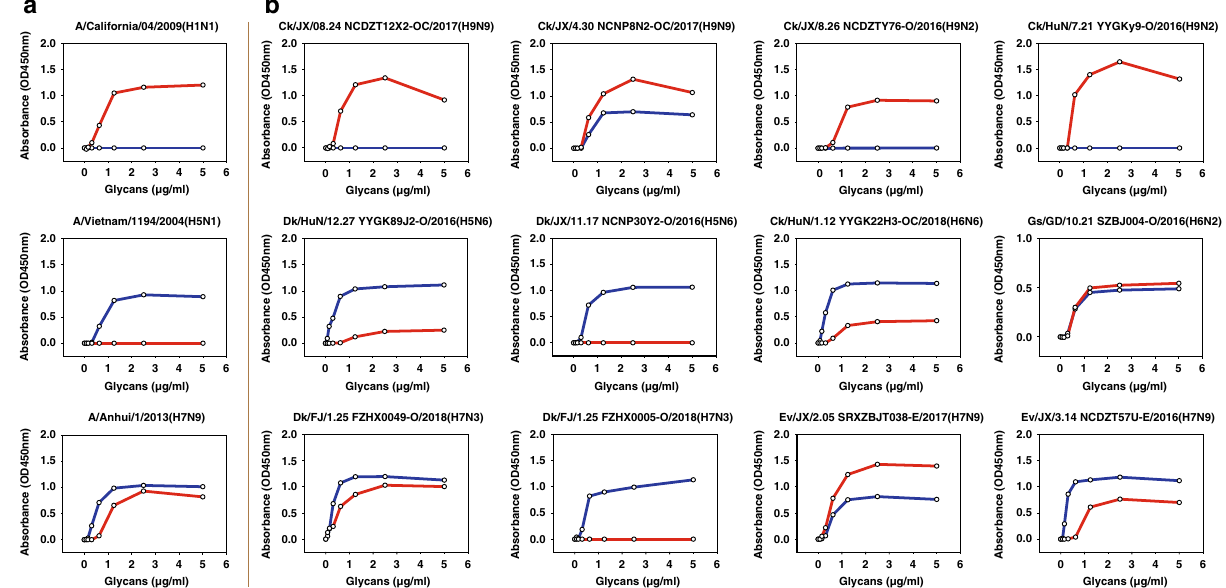
Fig. 5 Receptor-binding properties of representative AIV isolates. a A/Anhui/1/2013(H7N9) was used as a reference for comparison with the tested H7 strains. Two human strains, A/California/04/2009(H1N1) and A/Vietnam/1194/2004(H5N1), were used as controls. b Receptor-binding properties of the representative AIV strains to human ( α 2-6-SA) and avian ( α 2-3-SA) receptors were tested using the solid-phase direct binding assay with trisaccharide receptors. Red and blue lines represent human- and avian-type receptors, respectively. Two replications presented similar results and the mean values were shown. Source data are provided as a Source Data fi